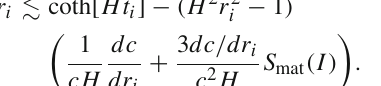
Fig. 6 The choice of Cauchy slice, the union of (cid:11) , I , and the red dashed line